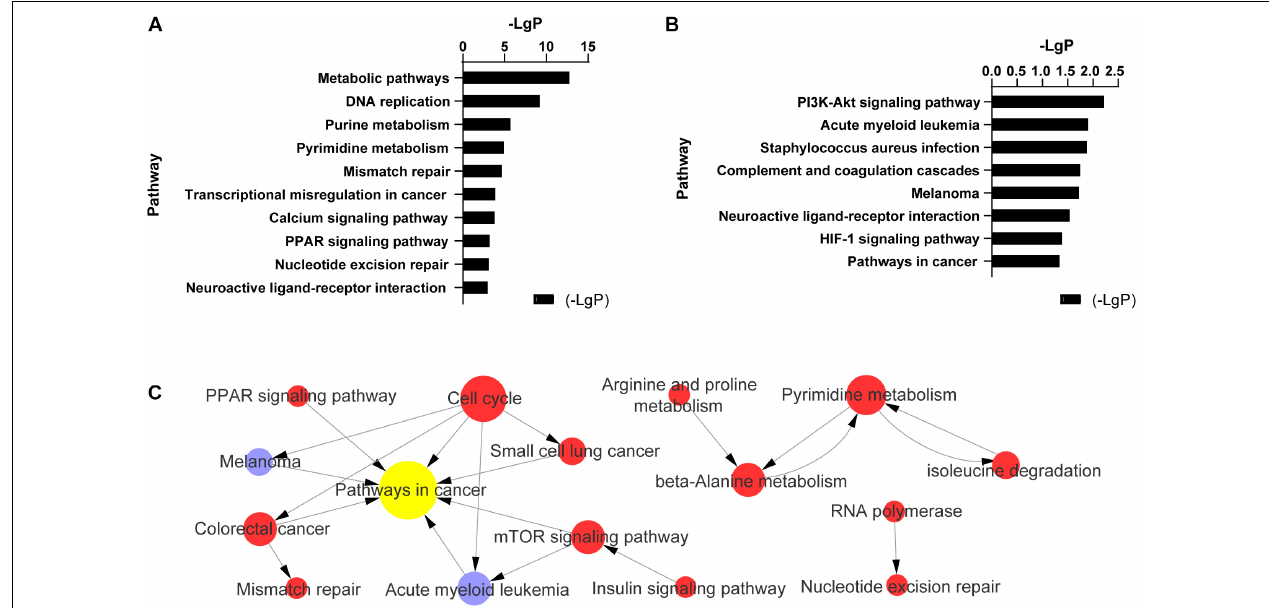
FIGURE 3 | Pathway analysis of 504 differentially expressed mRNAs in TC–EC interaction. (A) The most enriched 11 (-LgP > 3) of 40 pathways among up-regulated mRNAs (-LgP > 1). (B) The most enriched pathways among down-regulated mRNAs (-LgP > 1). The bar graphs represented the enrichment of these mRNAs. The value of (-LgP) was P -value taking the negative logarithm with base 10. (C) The interaction between the KEGG pathways of 504 differentially expressed mRNAs. The circle represents the pathway, and the size of the circle represents the degree of the pathway in the network. The larger the degree, the greater the circle, representing more pathway interaction. Lines between pathways represent their interrelationships. Red pathways represent the relative mRNAs that were upregulated, blue pathways represent the relative mRNAs that were downregulated, yellow represents the pathways with both up- and downregulated